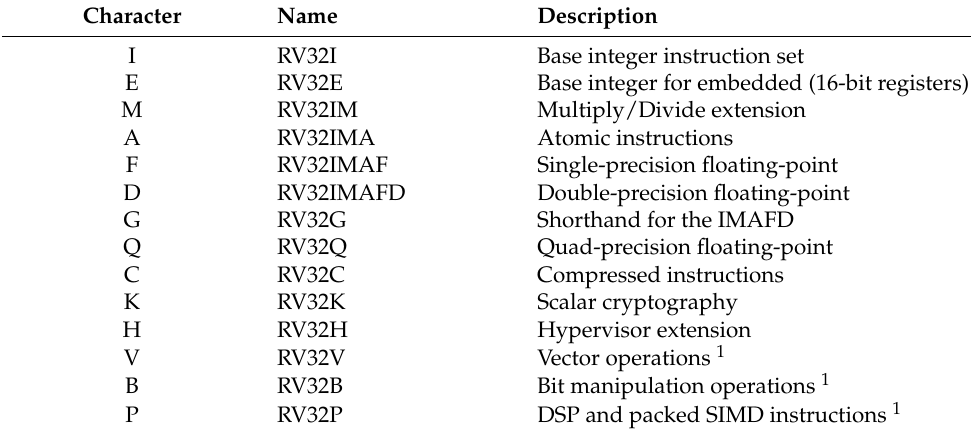
Table 1. RISC-V ISA standard and non-standard